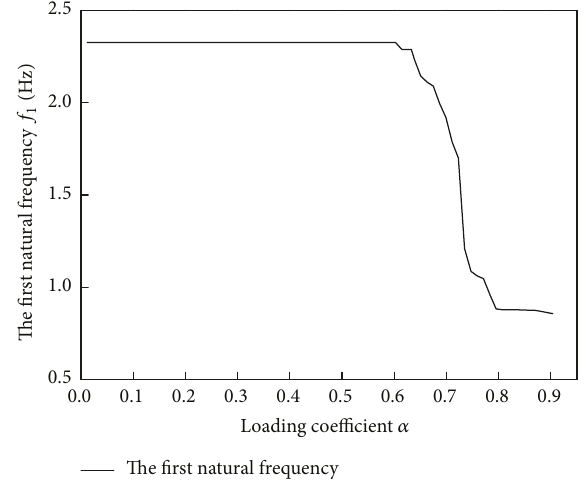
Figure 6: Variation of 𝑓 1 of the five-storey eccentric structure with 𝛼 .